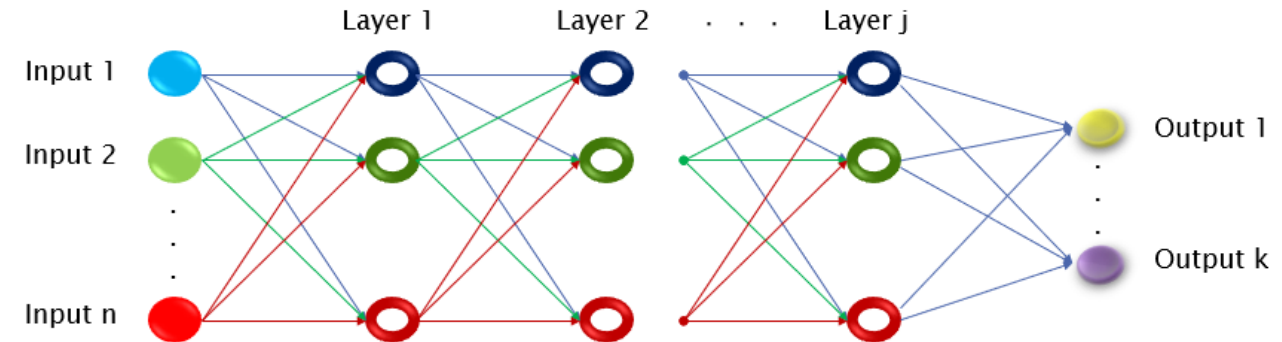
Figure 3. Schematic representation of a deep neural network. Each nod performs a single task through which the final outputs/results are synthesized.